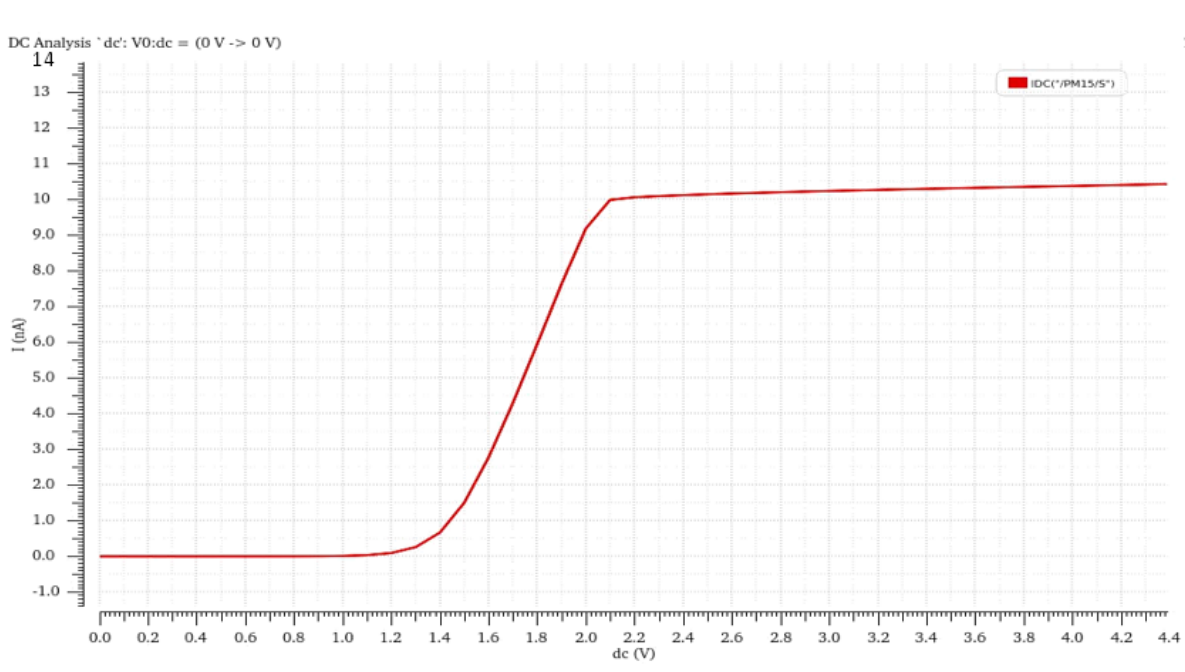
Figure 11. Relationship between the power supply voltage and output current. A transistor and a source-couple pair can generate voltage reference. Figure 12 shows the Monte Carlo simulation of nano-ampere. The mean and deviation of V ref are 653.89 mV and 16.67 mV, respectively, and the coefficient of variation ( σ / µ ) is 2.549%.